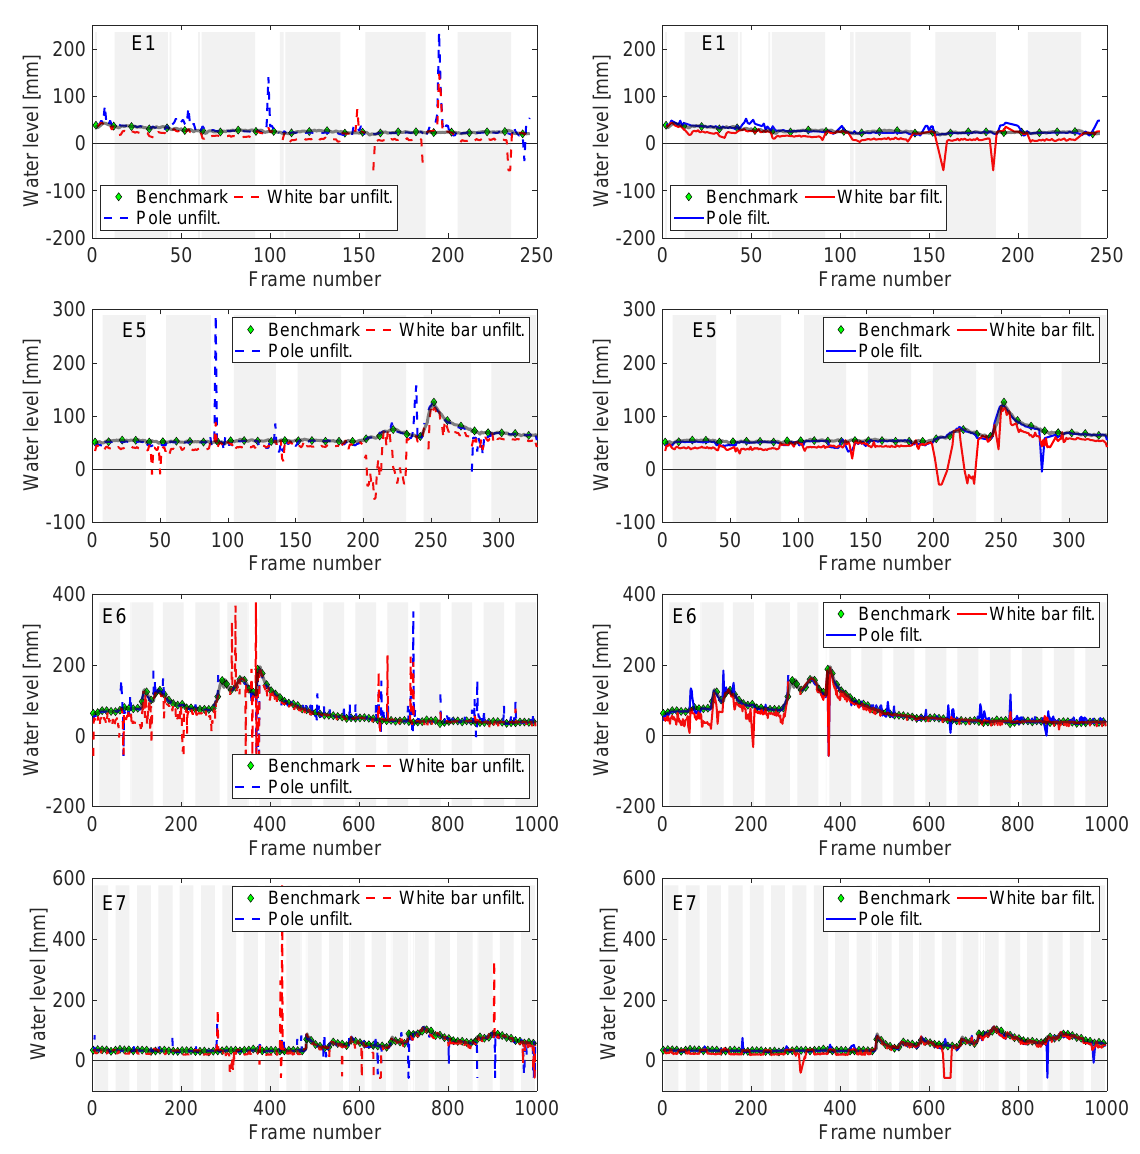
Figure 2. Unfiltered ( left ) and filtered ( right ) water levels computed from the pole and the white bar for experimental tests E1 and E5–E7. Benchmark water levels are in green markers and transparent black; pole unfiltered and filtered in dashed and solid blue, respectively; and white bar unfiltered and filtered in dashed and solid red, respectively. Light gray vertical bars indicate NIR